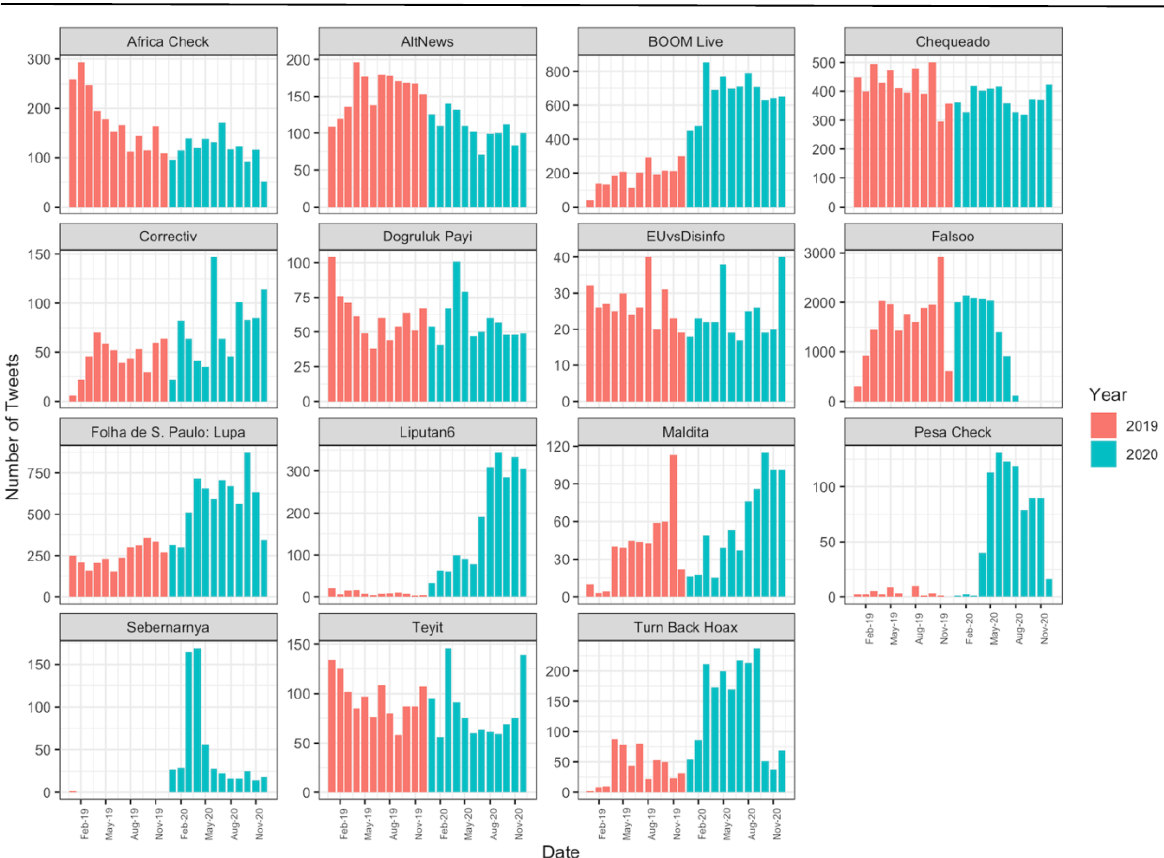
Figure 1. Number of tweets by fact checkers per month. The number of Tweets by fact-checking organizations on Twitter in 2019 and 2020 are shown as a time series. To be included in the dataset, each Tweet had to include a URL to a fact-checking organization’s website and had to come from the official Twitter handle of the fact -checking